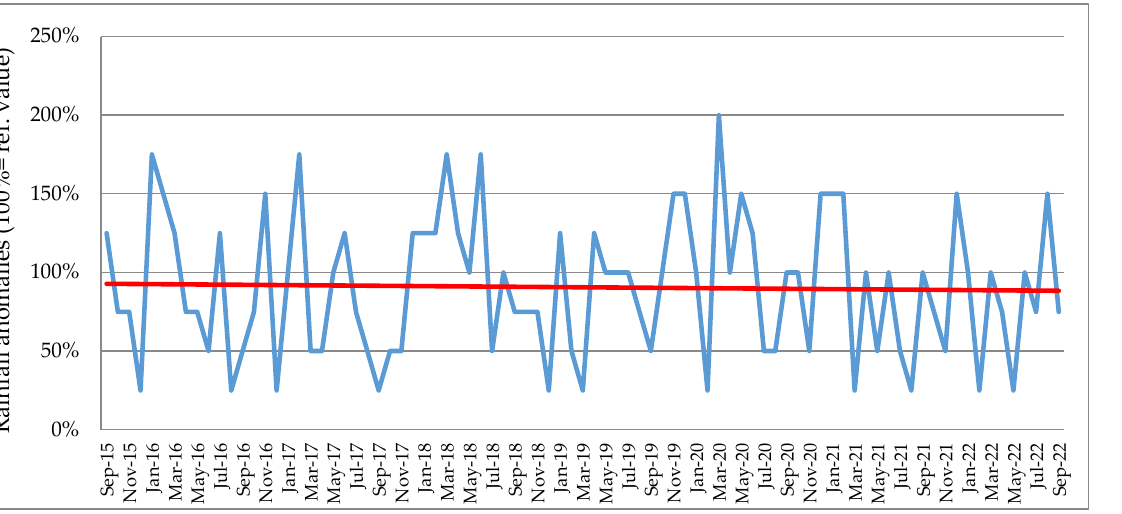
Figure 8. Rainfall anomalies in the upper G á llego River basin. September 2015–September 2022 (over 1981–2010 reference period, as determined by AEMET for these comparisons). Trend line (red). Data source and methodology: AEMET